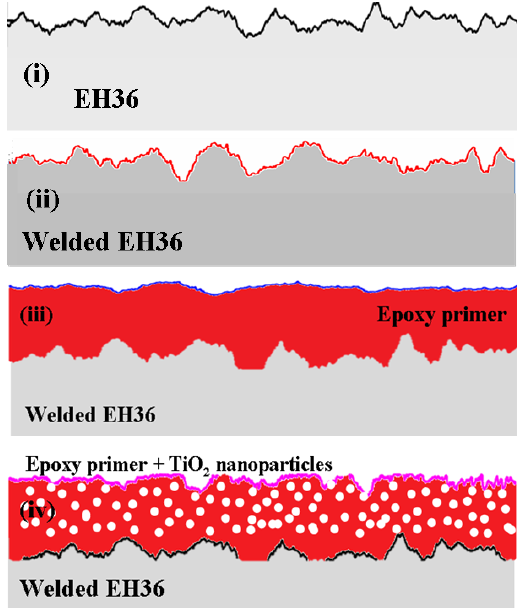
Figure 1. Scheme of studied samples with and without protective layers. ( i ) unprotected EH36 steel;